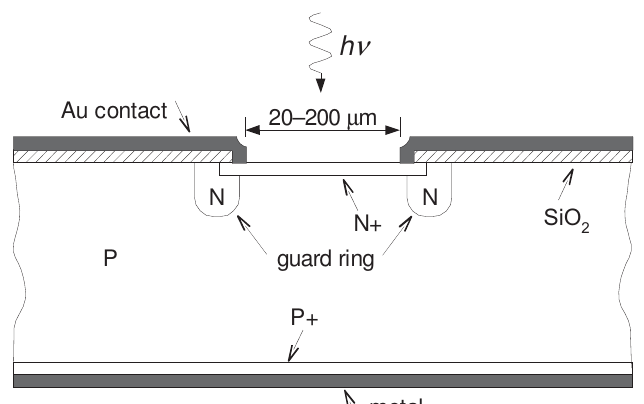
Figure 2. Cross-section of the K14 SPAD structure. The silicon bulk is p-doped, typical thickness of whole structure is 500 µm.